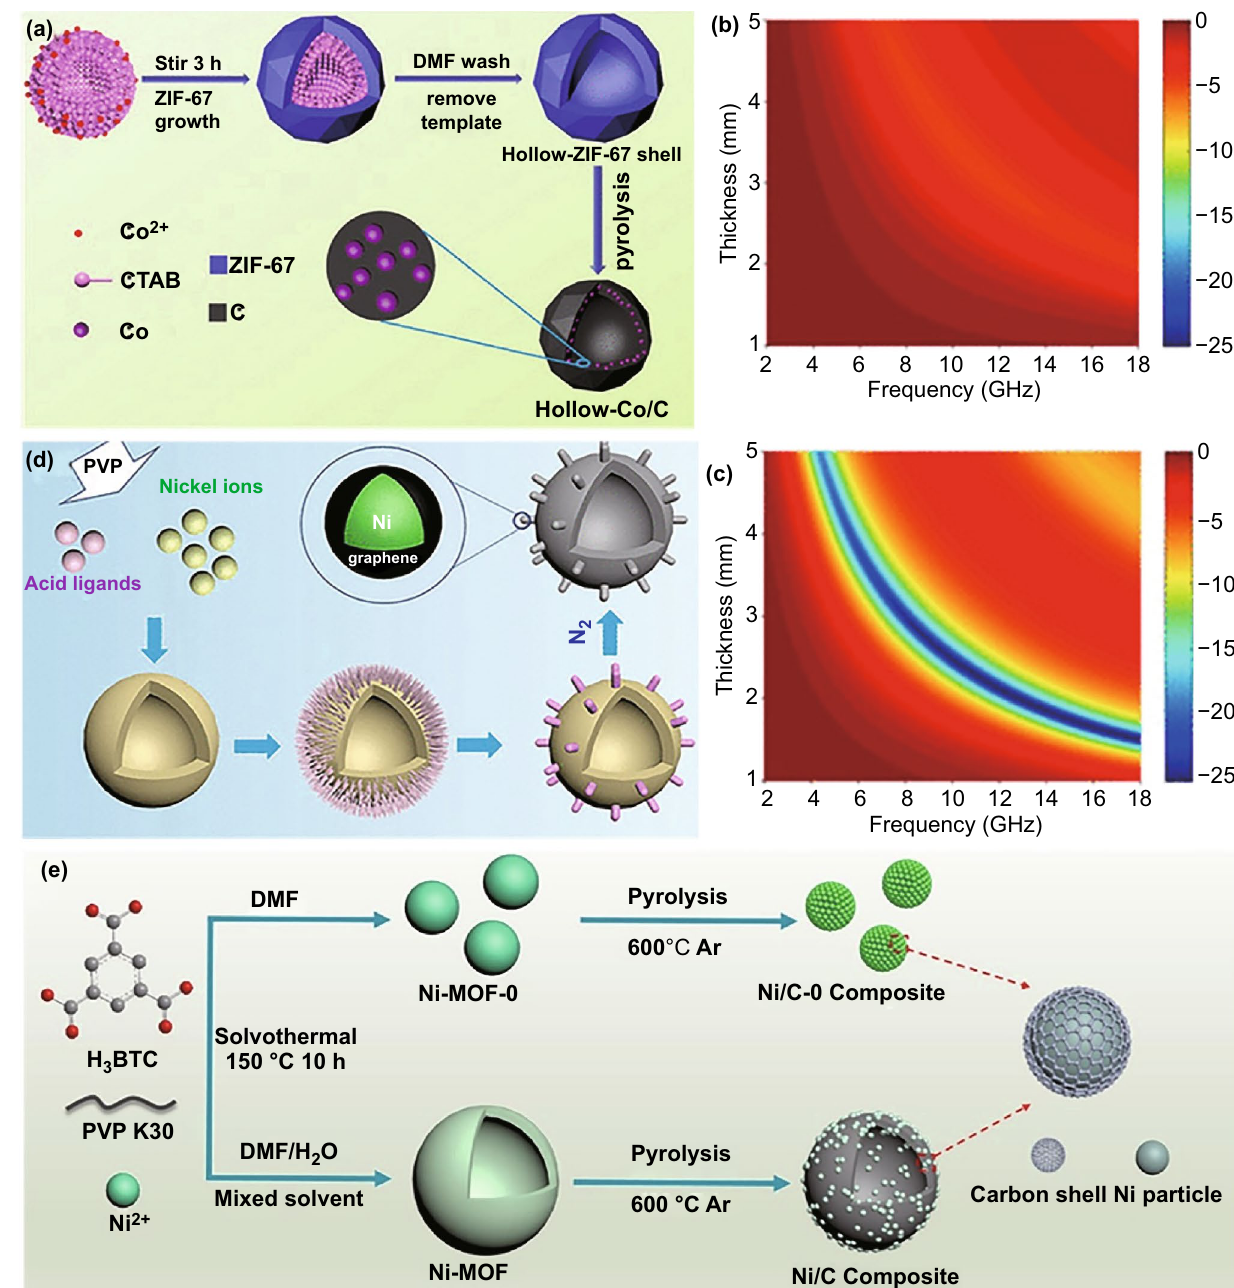
Fig. 8 a Schematic illustration of preparing hollow Co/C microspheres via a MOFs-derived strategy, RL maps of b Co/C and c Co/C-HS-600. Reproduced with permission from Ref . [143]. Copyright © 2018 American Chemical Society . d Illustration for the formation of Ni-MOF hollow spheres with controllable surface architecture. Reproduced with permission from Ref. [145]. Copyright © 2019 American Chemical Society. e Schematic illustration of the formation of Ni/C composites. Reproduced with permission from Ref . [32] . Copyright © 2019 Elsevier